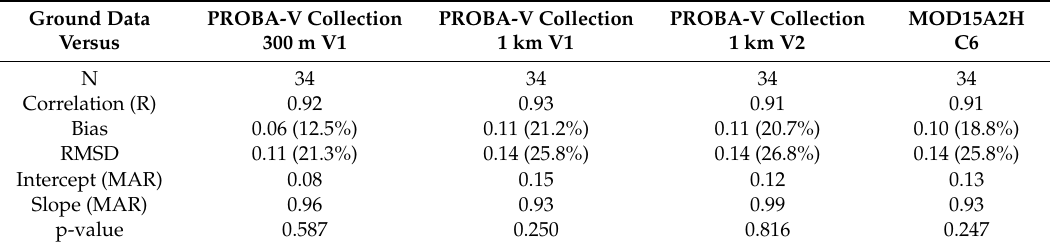
Figure 9. Comparison of satellite fAPAR products (Collection 300 m V1 ( a ), Collection 1 km V1 ( b ), Collection 1 km V2 ( c ) and MODIS C6 ( d )) with ground-based maps. Numbers indicate the sample (Table 4), and colours indicate the site (legend in Figure 10). Dashed lines correspond to the 1:1 line and optimal and target requirements, and the red line corresponds to the linear fit using MAR. Table 12. Accuracy assessment with ground measurements statistic for different satellite fAPAR products at 3 km spatial resolution. Relative values (%) are shown in brackets.